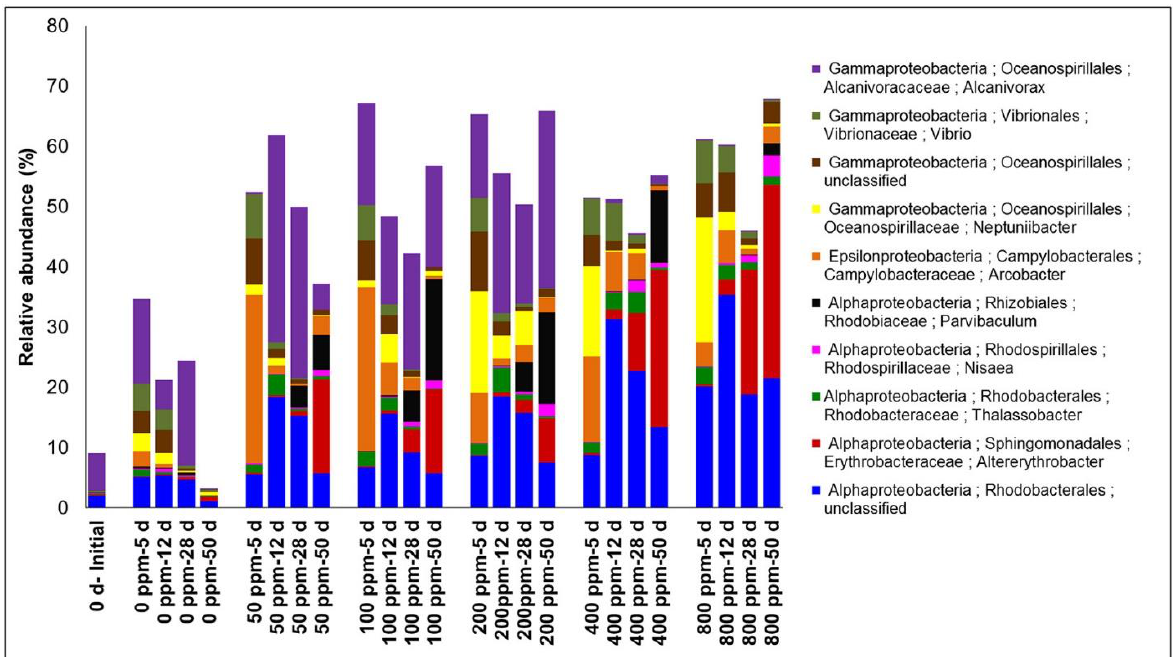
Figure 9. Relative abundances of potential biodegrading bacteria (at genus level) during the incubation of seawater with crude oil. Performed under controlled conditions of 0, 50, 100, 200, 4000 and 800 ppm oil in water and analyzed for initial community and 5, 12, 28 and 50 d of incubation. Adapted from Bacosa, et al. [40].